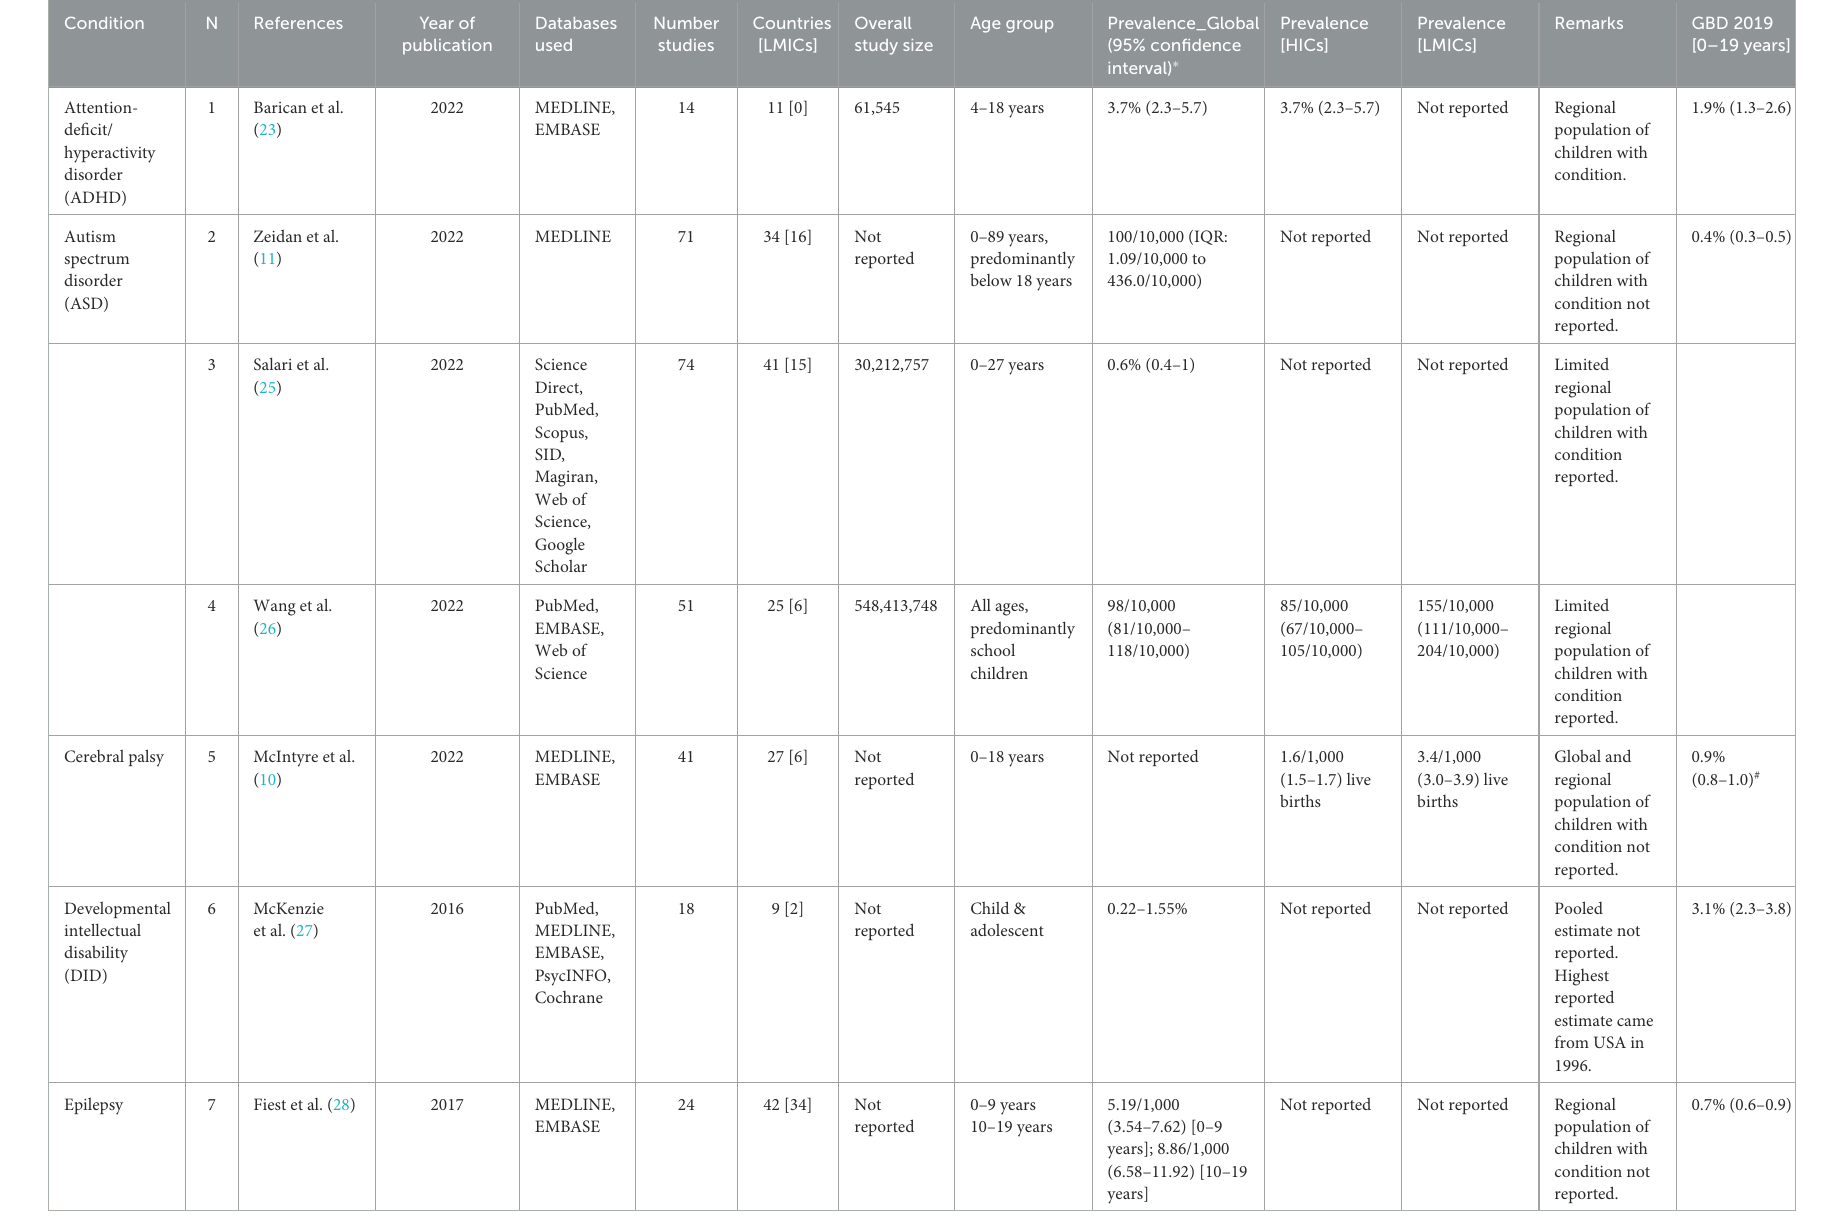
TABLE 1 Prevalence estimates of developmental disabilities in children and adolescents reported in systematic reviews (2015–2022) compared to GBD 2019